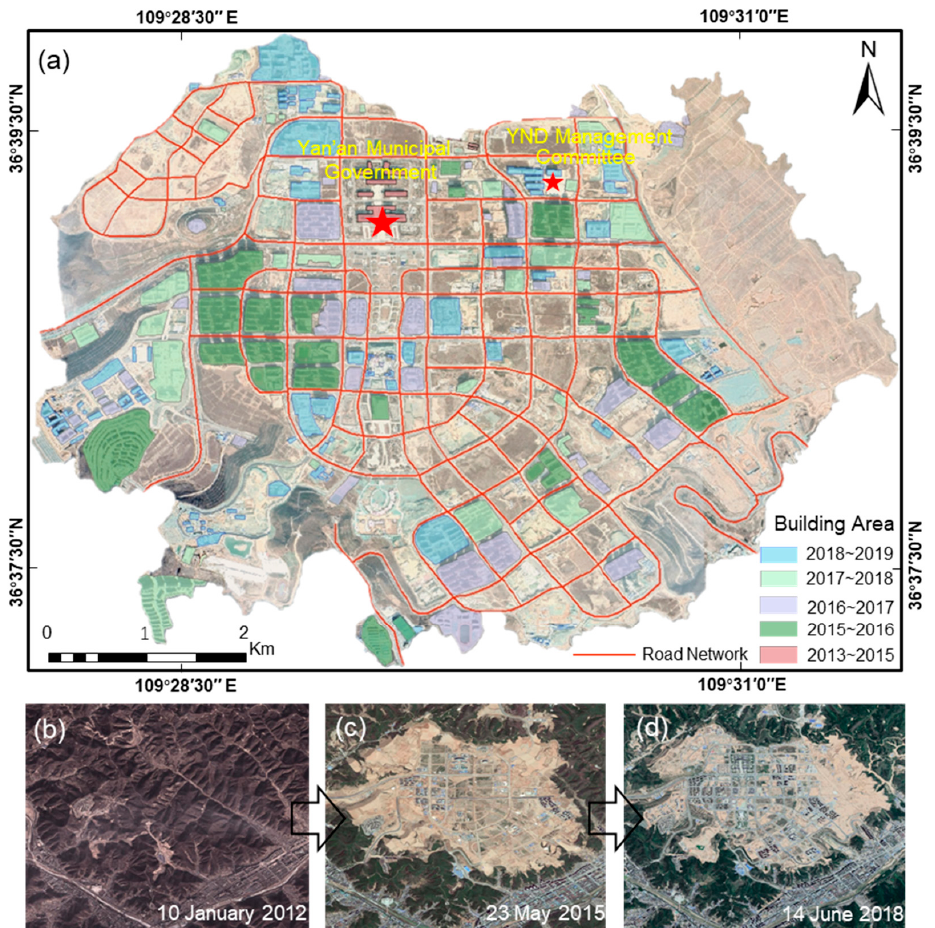
Figure 13. ( a ) The change of the buildings area and road network from 2013 to 2019. ( b – d ) Change of landscape in YND based on Google Earth images.